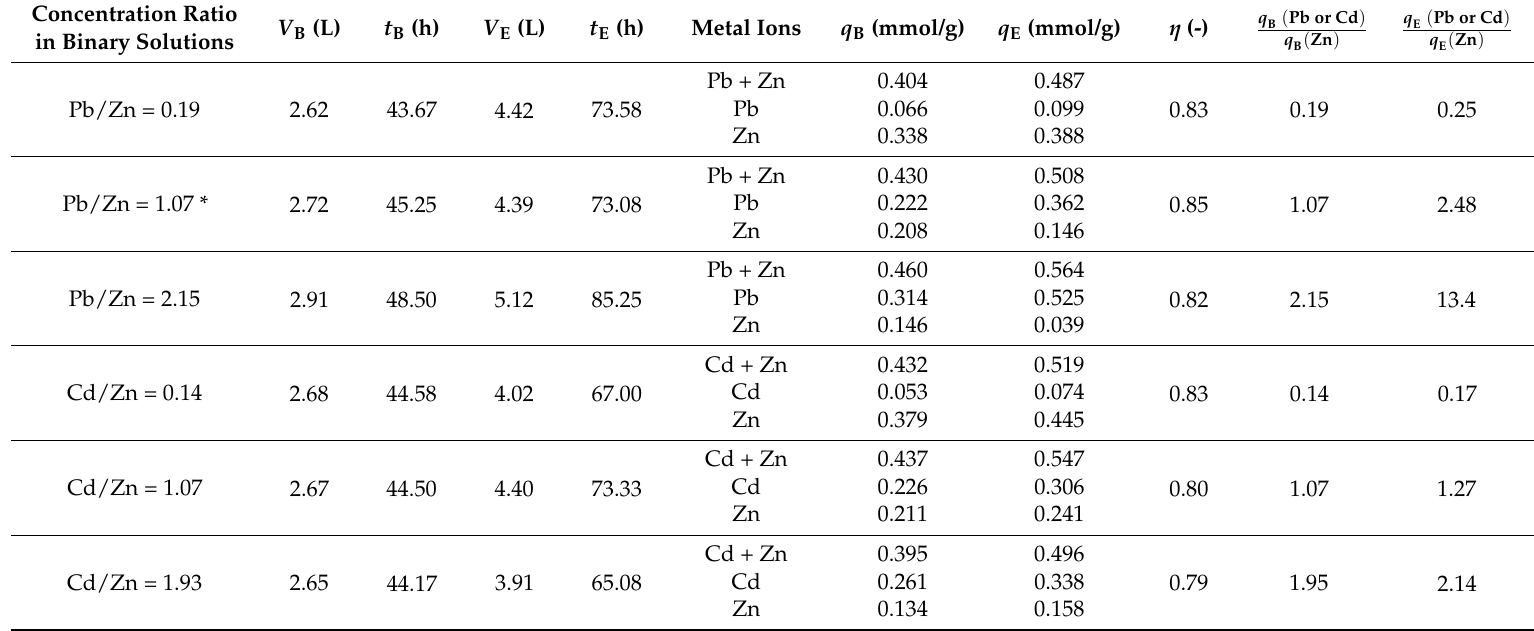
Table 1. The parameters of service cycles calculated from breakthrough curves for the (Pb + Zn) and (Cd + Zn) binary systems. Concentration Ratio in Binary Solutions Pb/Zn =